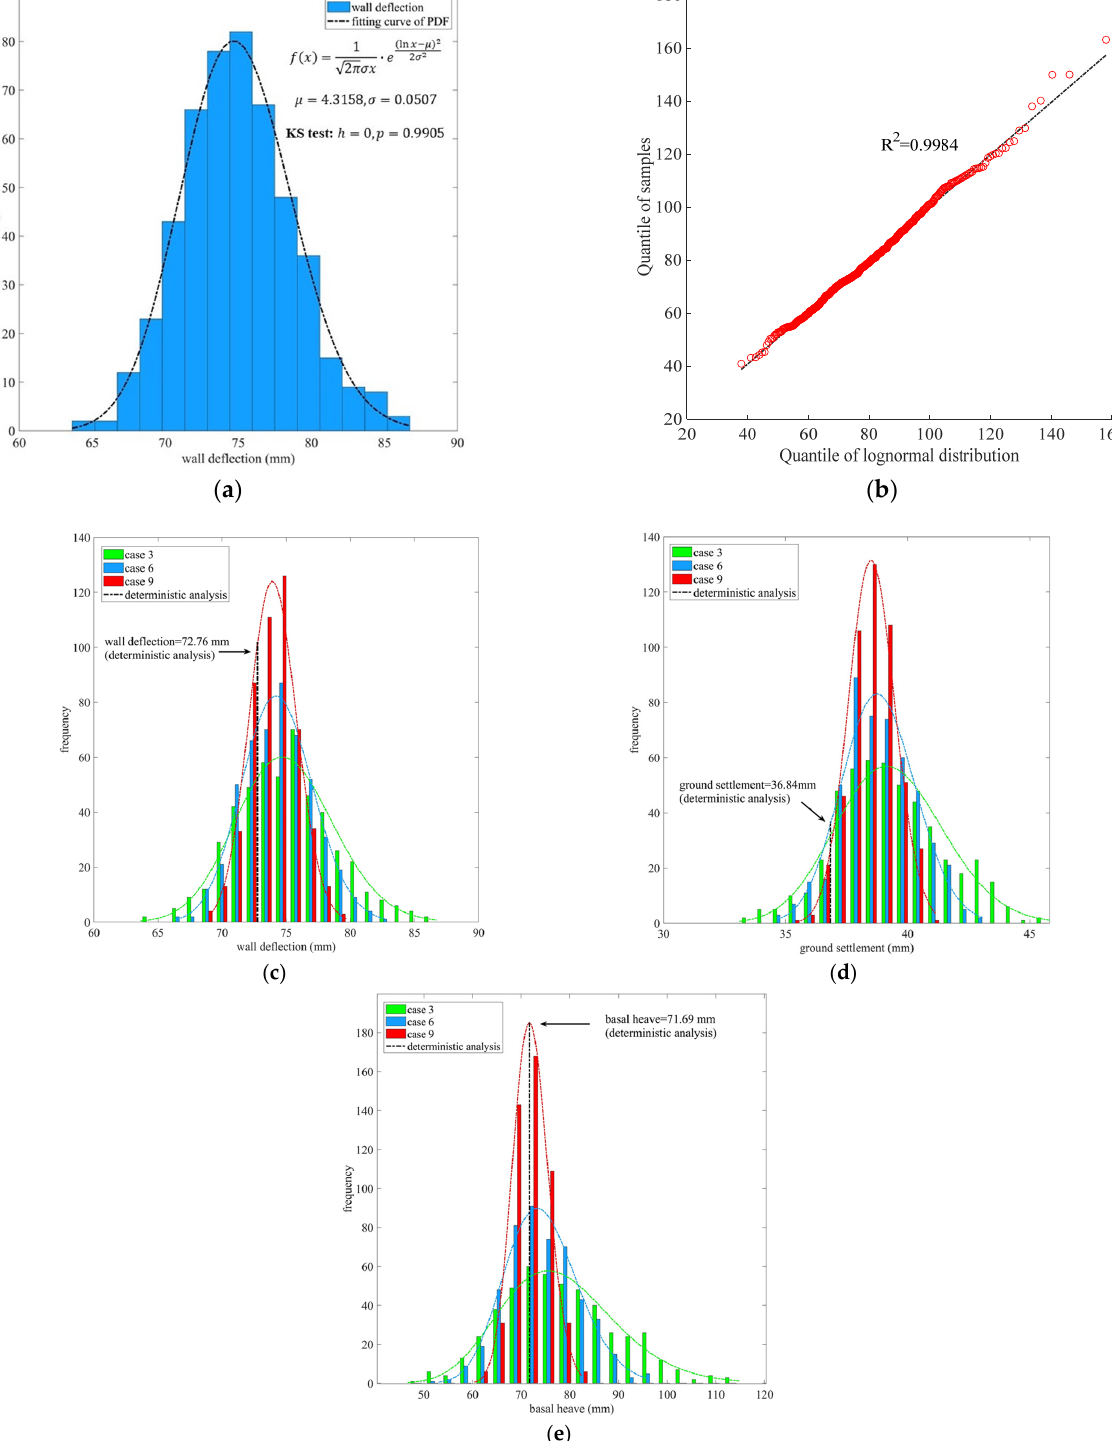
Figure 6. Statistical distribution of excavation responses: ( a ) histogram of wall deflection in case 3; ( b ) Quantile-Quantile plot of wall deflection; ( c ) histogram of wall deflection with different COVc u ; ( d ) histogram of ground settlement with different COVc u ; ( e ) histogram of basal heave with different COVc u .